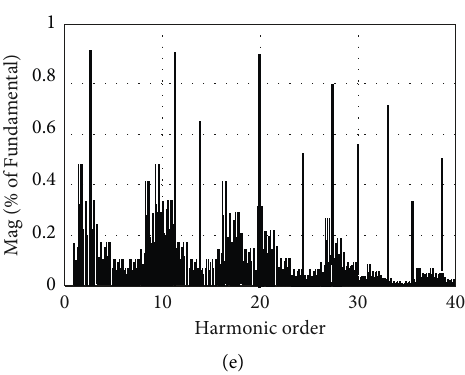
Figure 9: Simulation results (full compensation run). (a) A-phase grid voltage waveform. (b) A-phase grid current waveform. (c) A-phase compensation current waveform. (d) A-phase load current waveform. (e) FFT analysis of grid current. Table 1: Optimization effect of microgrid system operation based on intelligent system